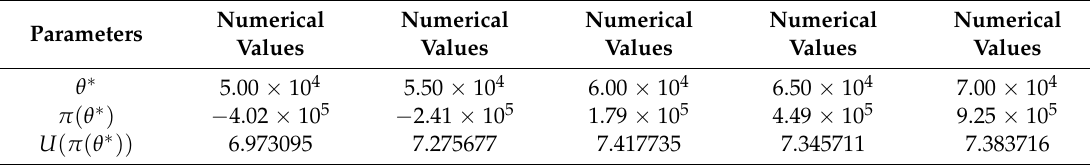
Table 2. Analysis of numerical